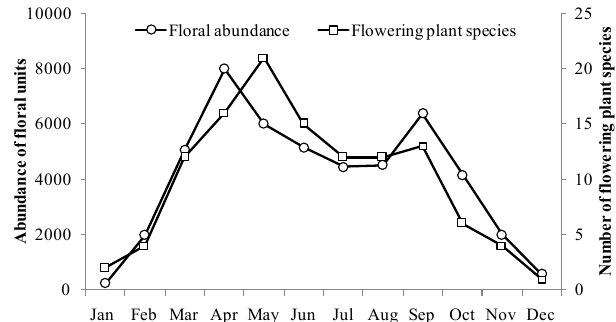
Fig 3 . Availability of floral resources (number of flowering plant species and floral abundance) at Bahauddin Zakariya University Campus, Multan, Pakistan during January to December, 2008.